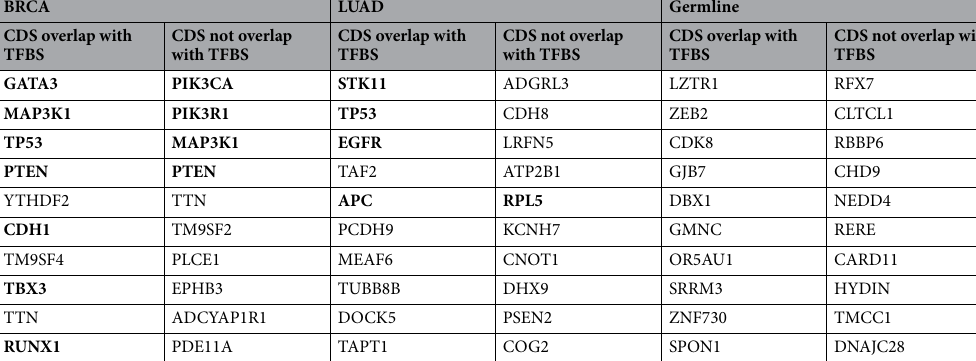
Table 5. Top ten genes with multiple high phyloP scores (> 5) in somatic CDS indels. *The genes in bold are among the125 SMG list.